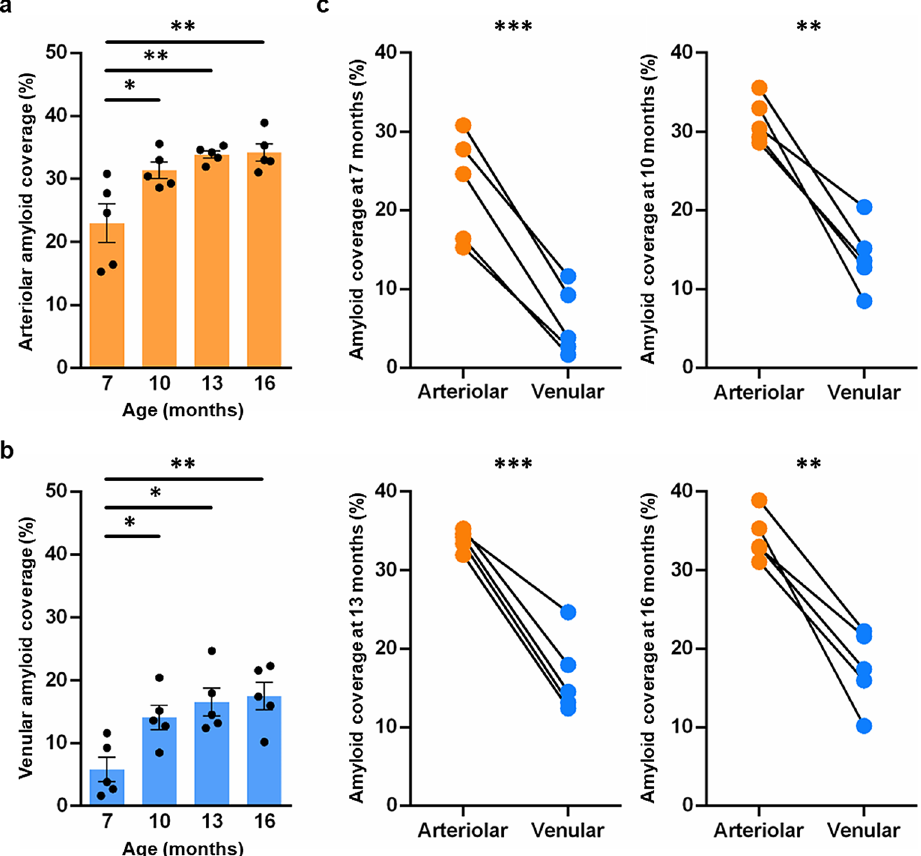
Figure 3. Percent arteriolar and venular amyloid load with disease progression. Percent vascular amyloid coverage was determined by quantifying area of ThioS over area of lectin-labelled vessels. Arteriolar ( a ; p = 0.0001 ) and venular amyloid ( b ; p = 0.004 ) increases significantly with disease progression. The majority of amyloid increased between 7 and 10 months of age for both arteriolar (p = 0.02) and venular amyloid (p = 0.05). Using two-tailed t-tests statistical approach, the scatter plot comparing percent amyloid load between arterioles and venules ( c ) demonstrates significant arteriolar amyloid relative to venular amyloid within each individual rat: 7 (p = 0.006), 10 (p = 0.021), 13 (p = 0.0008), and 16 months of age (p = 0.019). Alpha = 0.05. Graphs are labelled as the mean of five replicates ± sem. (*p ≤ 0.05, **p ≤ 0.01, ***p ≤ 0.001, ****p <